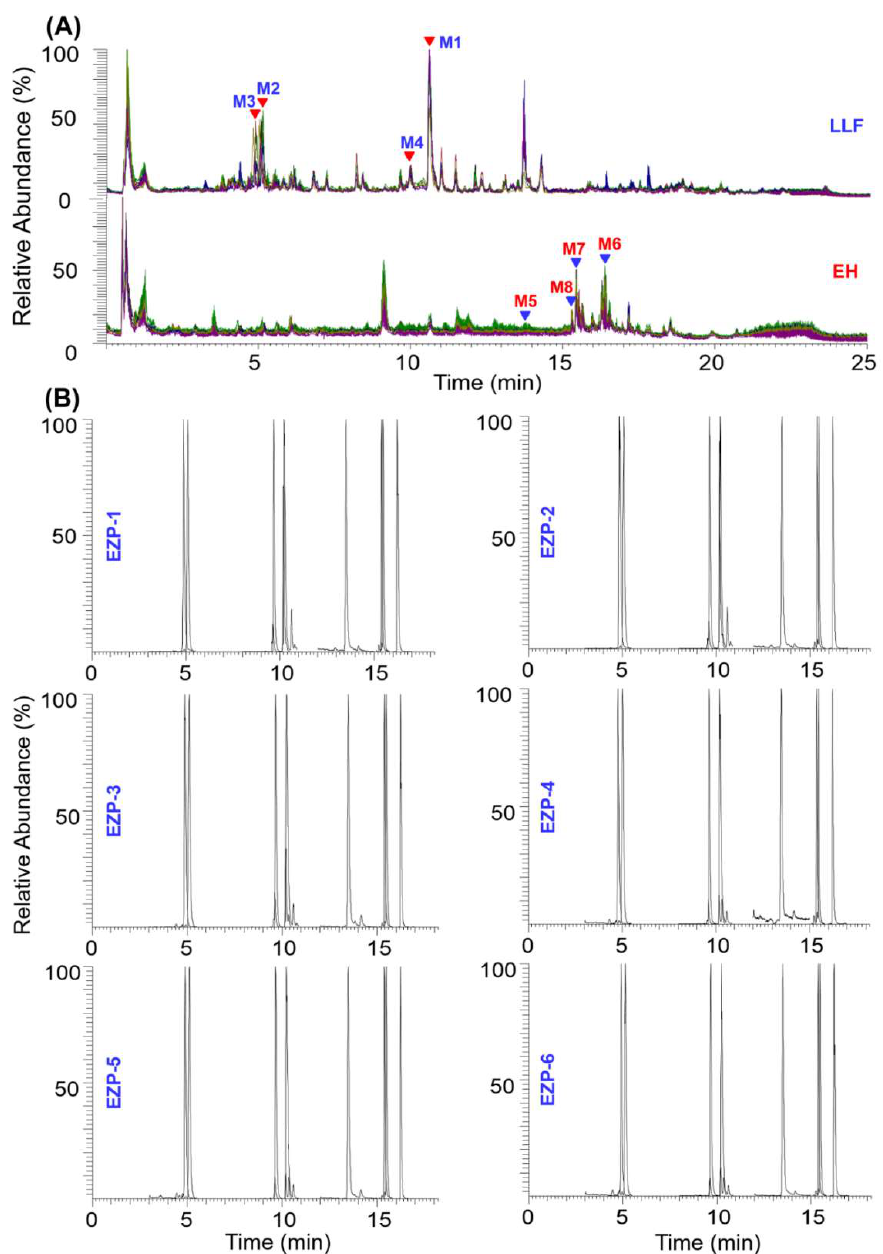
Figure 5. Overlapped fingerprints of two component drugs Ligustri Lucidi Fructus (LLF) and Ecliptae Herba (EH) under the same UHPLC/Q-Orbitrap MS condition (full scan in ESI− mode; A ) and the SIM spectra of six batches of commercial EZP samples ( B ).